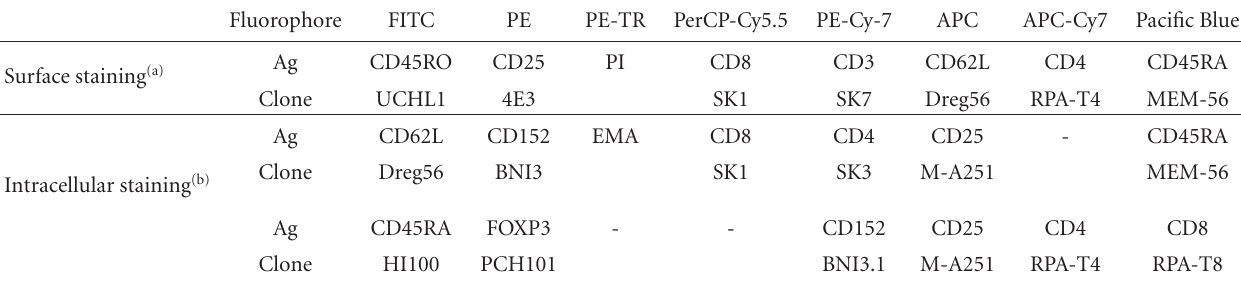
Table 1: Combinations of antibodies used in FACS